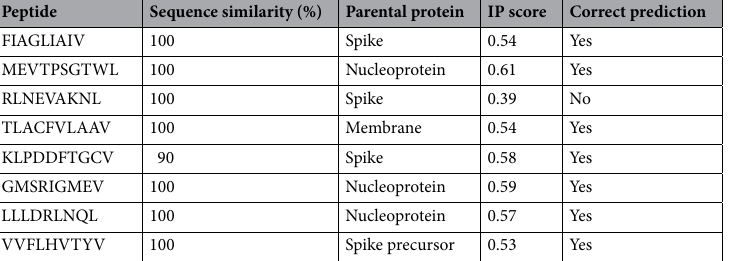
Table 1. Immune Presentation (IP) scores for validated SARS-CoV peptides with high similarity to SARS- CoV-2.